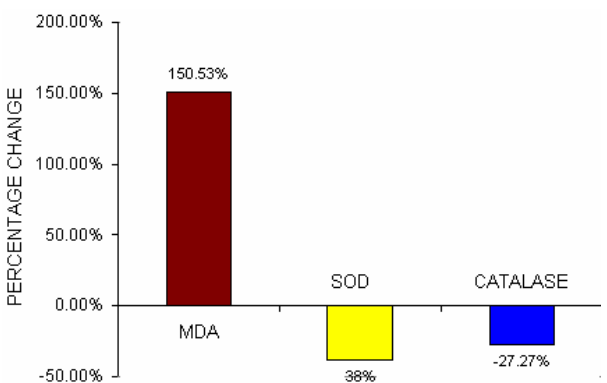
Figure 5: Percent change chart of serum malondialdehyde, erythrocyte-superoxide dismutase (SOD) and erythrocyte- catalase activities of lead exposed battery manufacturing workers (BMW) group of western Maharashtra (India) with respect to control group.